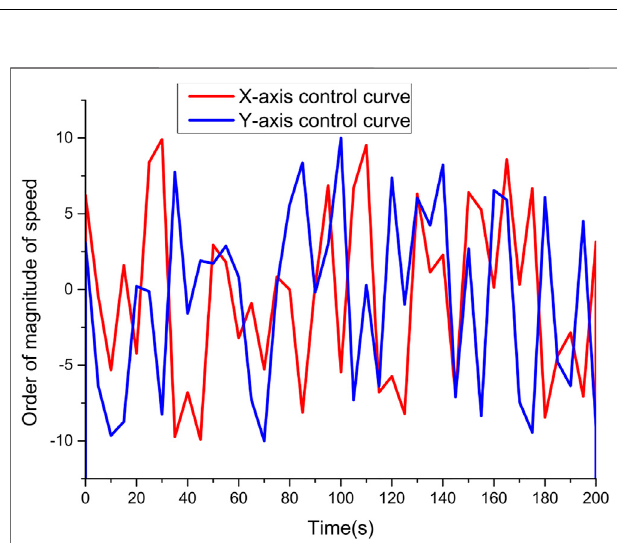
FIGURE 6 | Optimal control of human-dragged target tracking data.